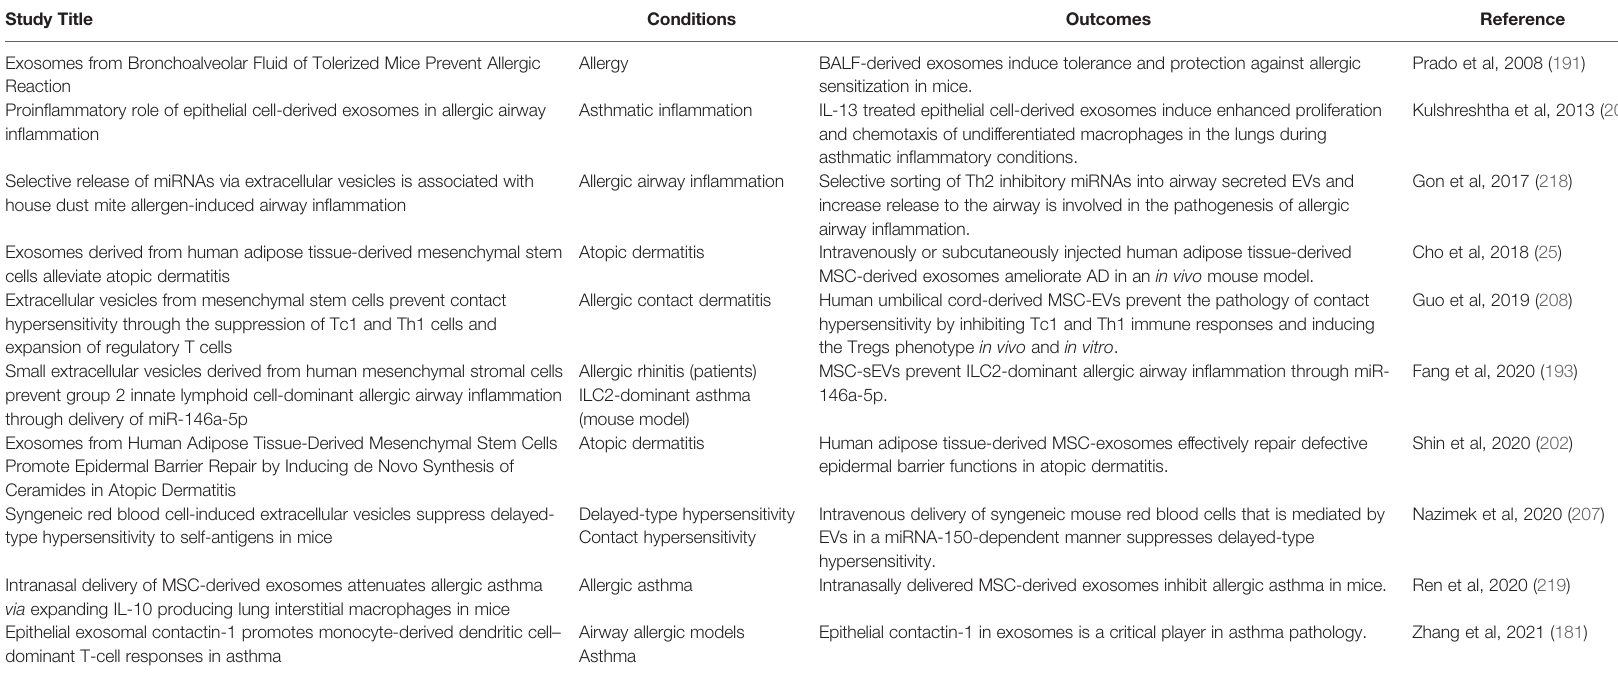
TABLE 2 | Preclinical models using EVs for allergy treatment in